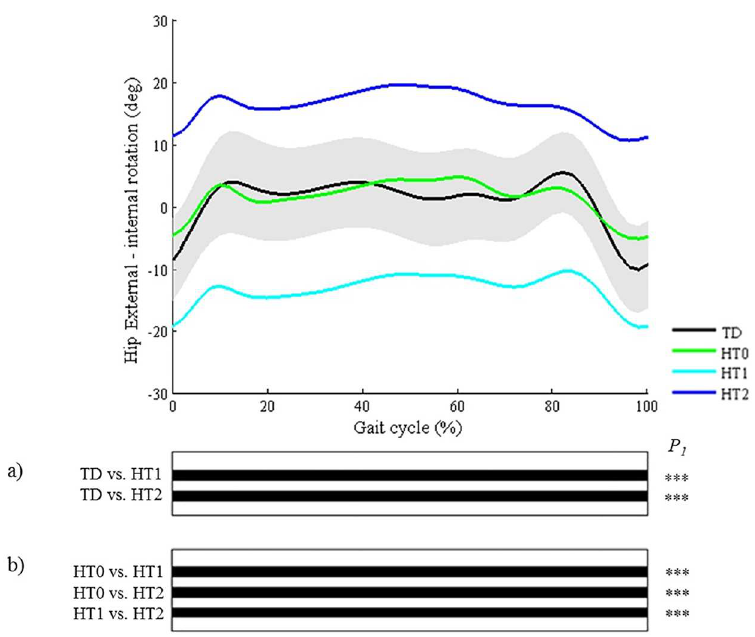
Fig 4. Hip in the transverseplane (HT). Top graph shows the mean kinematic angle of TD gait and of each consensus-based pattern of the hip in the transverse plane. Black bars indicatesignificantgait phases during which the SPM{t} statistic exceededthe critical threshold. Panel ( a ) shows results of hypothesis2 (i.e. unpairedt-tests, α = 0.01); panel ( b ) shows results of hypothesis3 (i.e. post-hoc unpairedt-tests, α = 0.003). * p < 0.01, ** p < 0.001, *** p < 0.00001.P 1 indicatesthe p-value of the first cluster duringthe gait